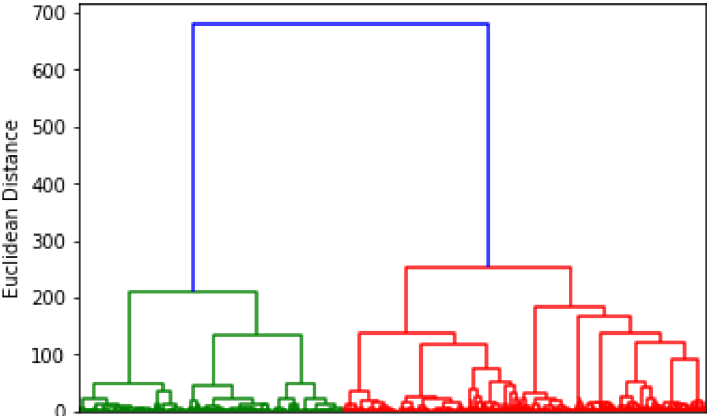
Figure 4. Classical dendrogram suggesting four potential clusters.